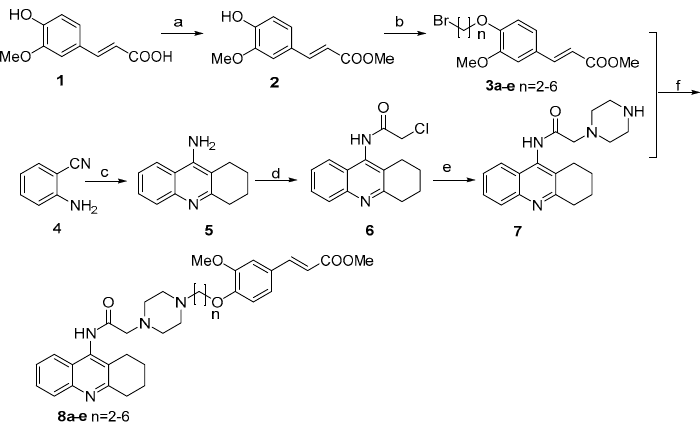
Scheme 1. The synthetic routes to TFAs.